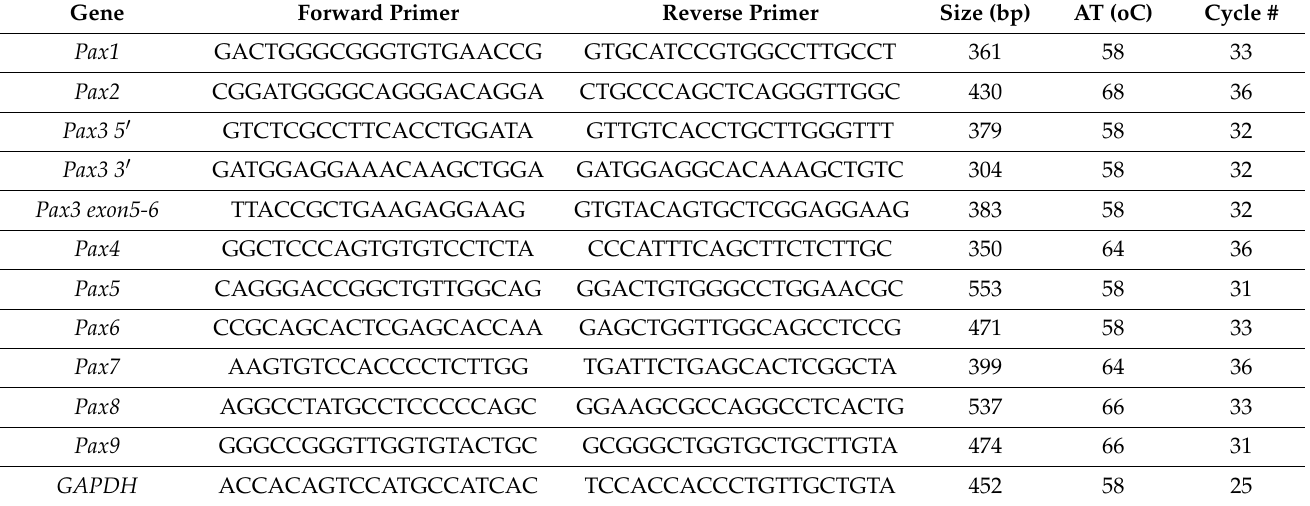
Table 1. Listing PCR primers with insert sizes, specific annealing (AT) temperatures and PCR cycle number. # stands for